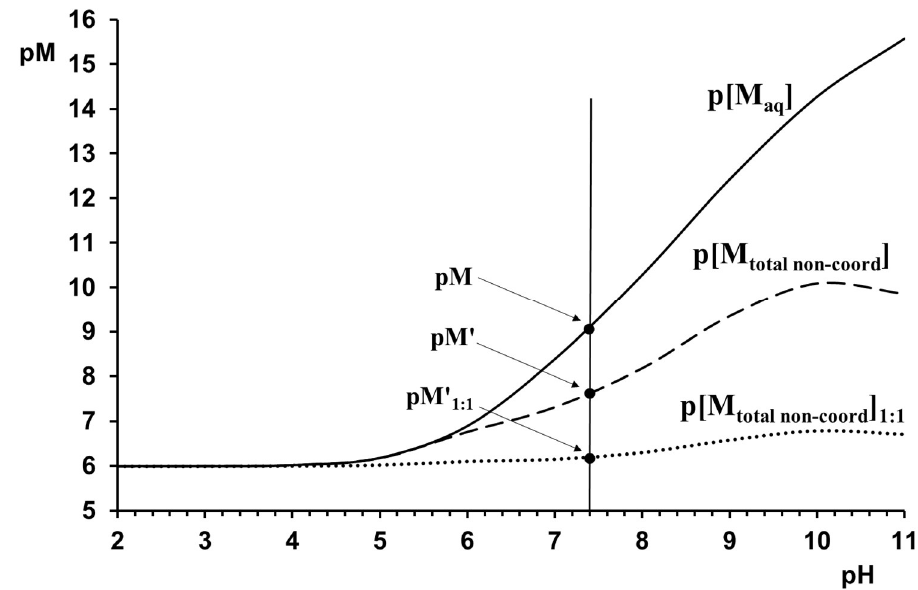
Figure 5. Dependence on the pH of p[M aq ] or p[M total non-coord ] at 1:10 metal ion-to-ligand ratio and p[M total non-coord ] 1:1 at 1:1 metal ion-to-ligand ratio calculated for the [( η 6 - p -cym)Ru(H 2 O) 3 ] 2+ –H 2 - γ - Abha + system (c M = 10 −6 M, I = 0.20 M KCl, t = 25 °C). (The pM, pM’ as well as pM’ 1:1 values can be read from the curves at pH = 7.4).